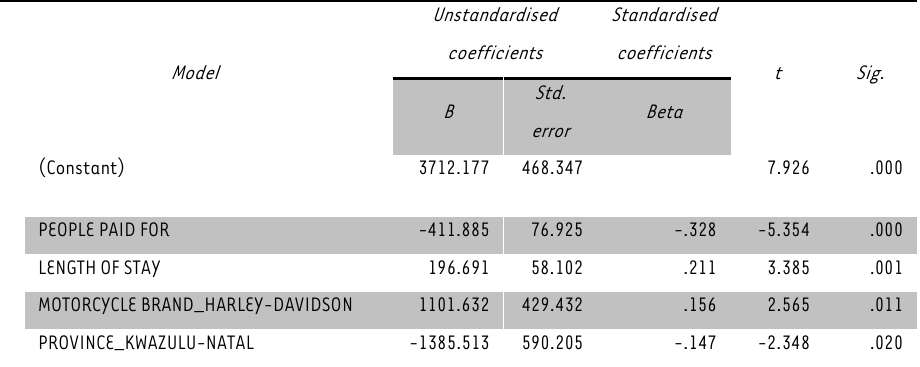
Results from the backward regression analysis: Spending per person Unstandardised coefficients Model